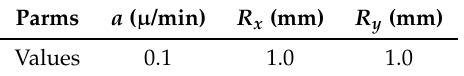
Table 1. The parameter values of tool influence function